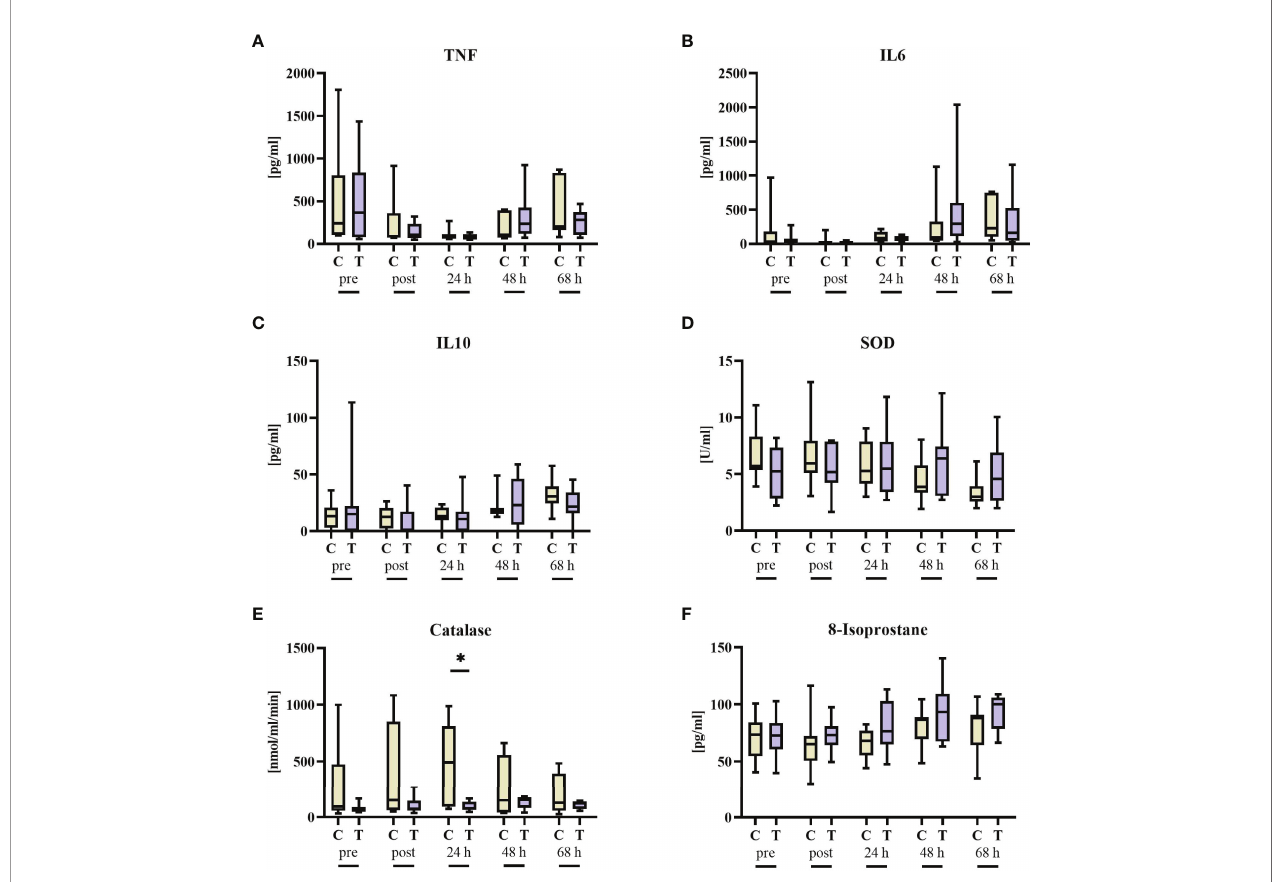
FIGURE 4 | In fl ammation parameters before (pre) and after 3 h of hemorrhagic shock (post) as well as 24 h, 48 h, and 68 h after resuscitation. (A) TNF, (B) IL6, (C) IL10, (D) superoxide dismutase (SOD), (E) catalase, and (F) 8-isoprostane. n = 8/9 before shock, 8/9 after shock, 8/9 at 24 h, 7/9 at 48 h, and 7/8 at 68 h animals per group for vehicle control (yellow, C) and thiosulfate (purple, T), respectively. * = p < 0.05, Mann-Whitney U test. Box plots report median, interquartile range, minimum, and maximum.